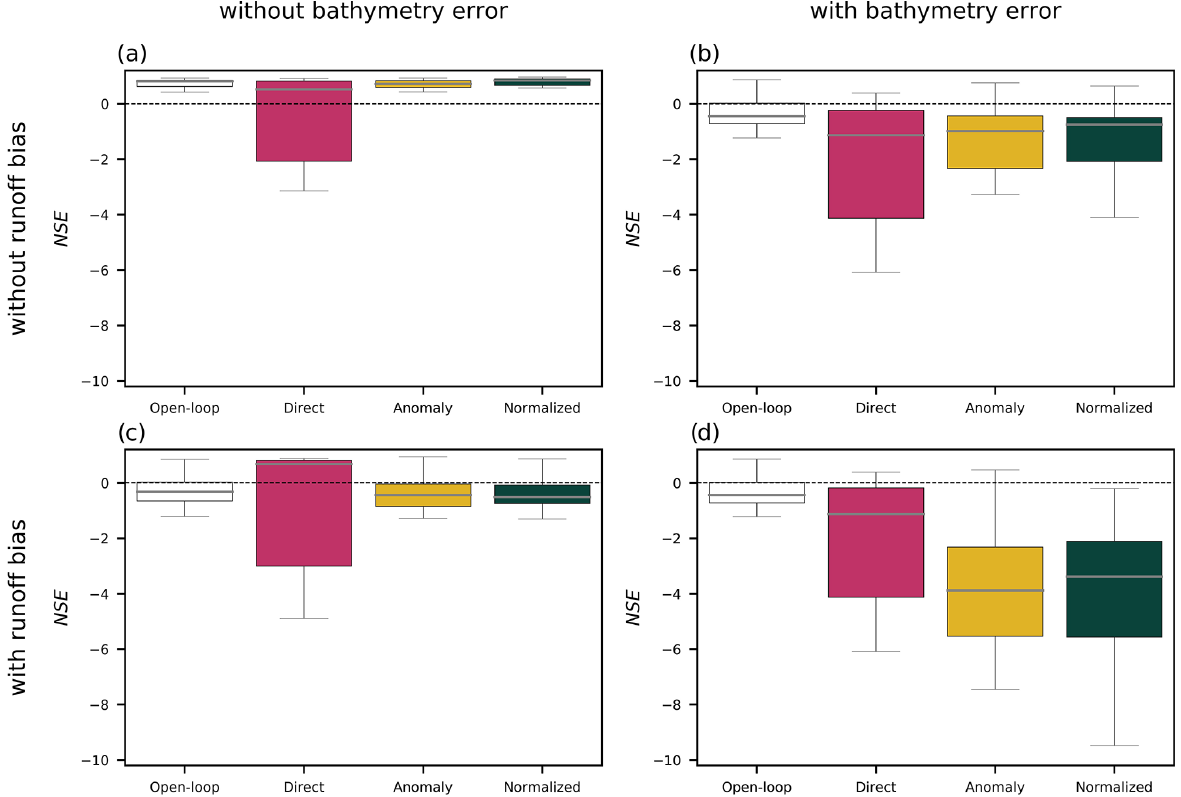
Figure 11. Comparison of the Nash–Sutcliffe efficiency ( NSE ) of assimilated river discharge under various conditions: (a) without runoff bias or bathymetry error, (b) without runoff bias and with bathymetry error, (c) with runoff bias and without bathymetry error, and (d) with runoff bias and bathymetry error. The direct, anomaly, and normalized value DA results are represented in blue, yellow, and red,